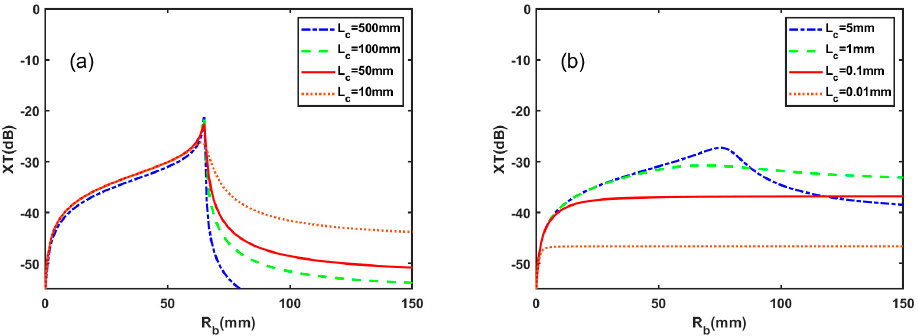
Figure 6. ( a ) Crosstalk as a function of bending radius, for correlation length, 500 mm, 100 mm, 50 mm, and 10 mm; ( b ) crosstalk as a function of bending radius, for correlation length, 5 mm, 1 mm, 0.1 mm, and 0.01 mm.